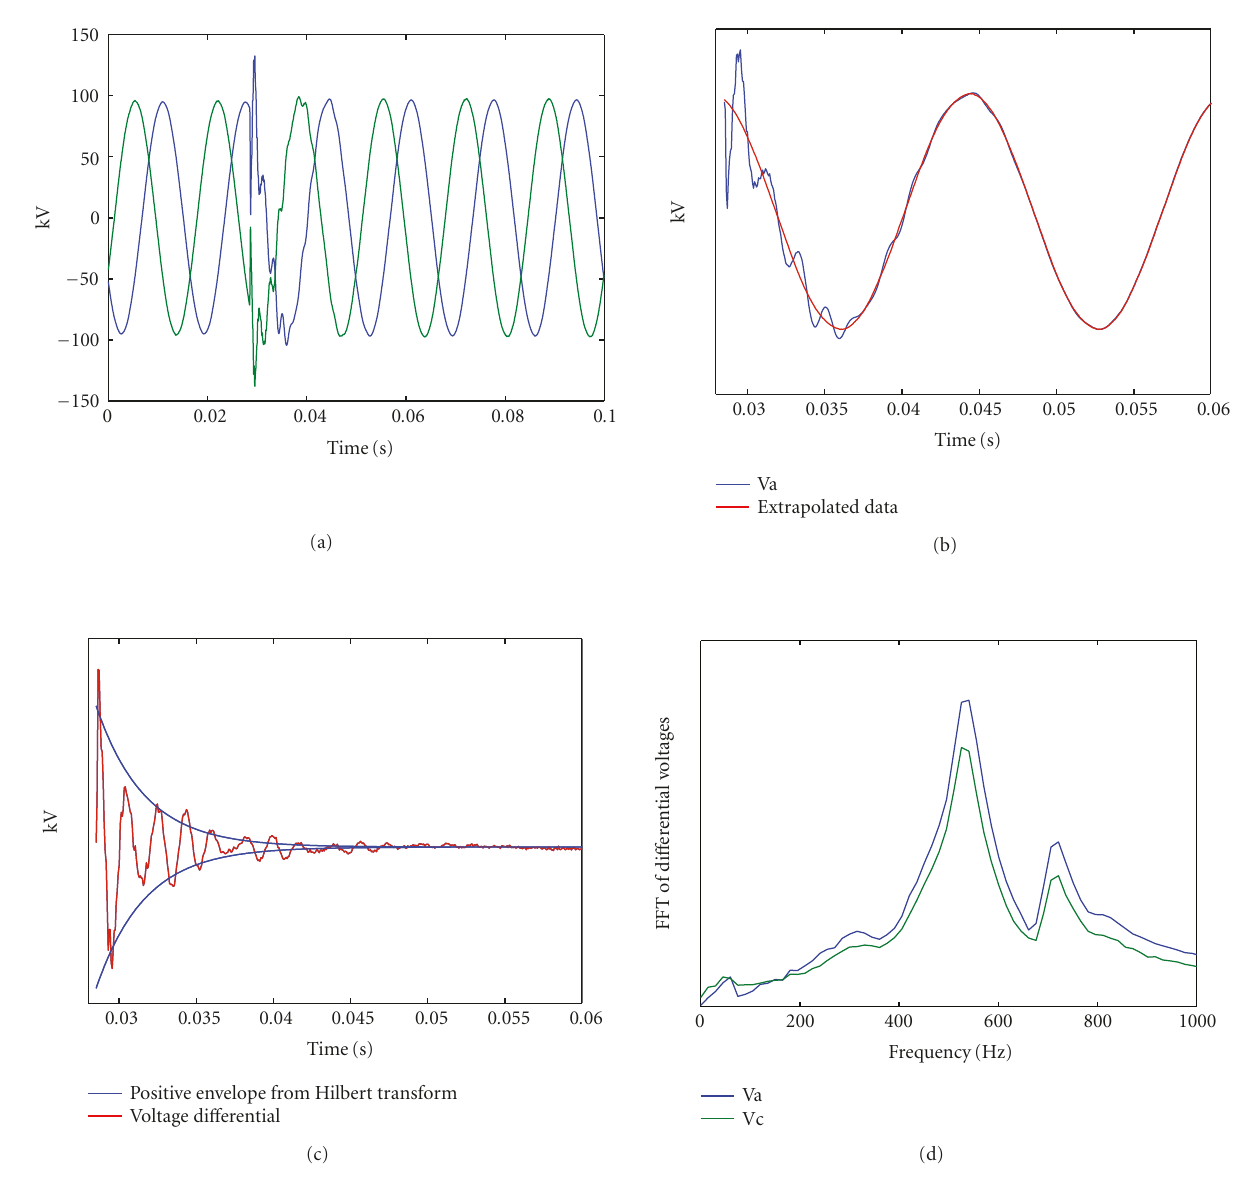
Figure 8: Application of the damping estimation method to actual data: (a) voltage waveform of phase A (bold) and C, (b) Phase A voltage transient and the extrapolated voltage after capacitor switching, (c) positive and negative envelope of voltage A detected by Hilbert damping analysis, (d) spectral information of the di ff erential voltage A and